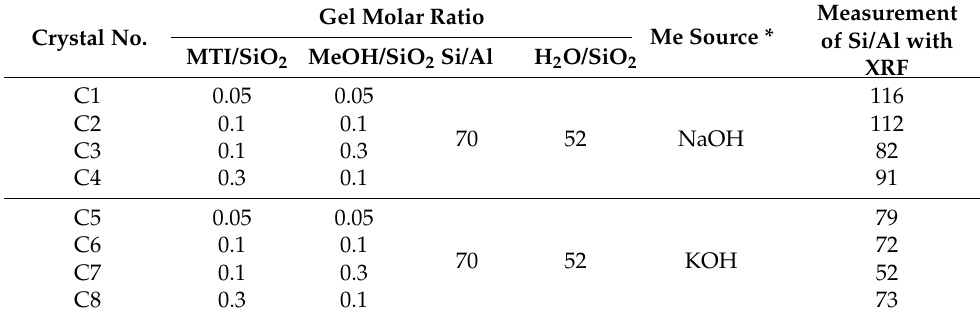
Table 1. Si/Al molar ratios of ZSM-58 crystals at various gel compositions at 423 K for 24 h. Measurement Gel Molar Ratio Me Source * Crystal No. of Si/Al with XRFMTI/SiO 2 MeOH/SiO 2 Si/Al H 2 O/SiO 2 C1 0.05 0.05 116 C2 0.1 0.1 70 52 NaOH